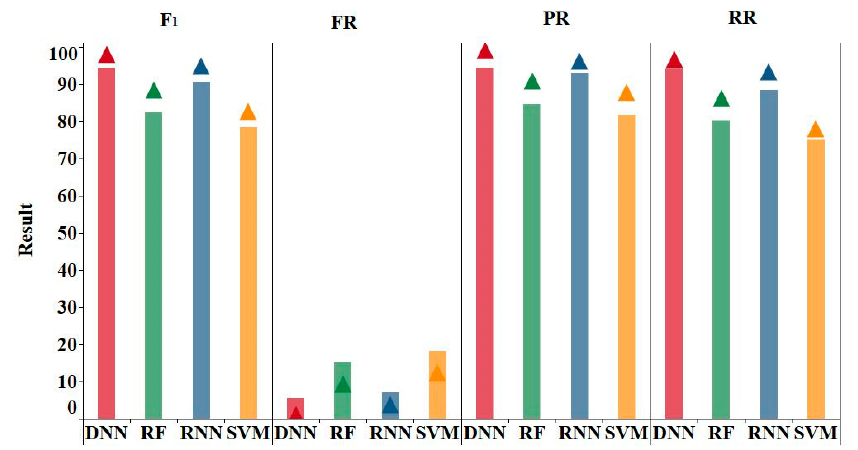
Figure 9. Risk prediction for concurrent medical use.